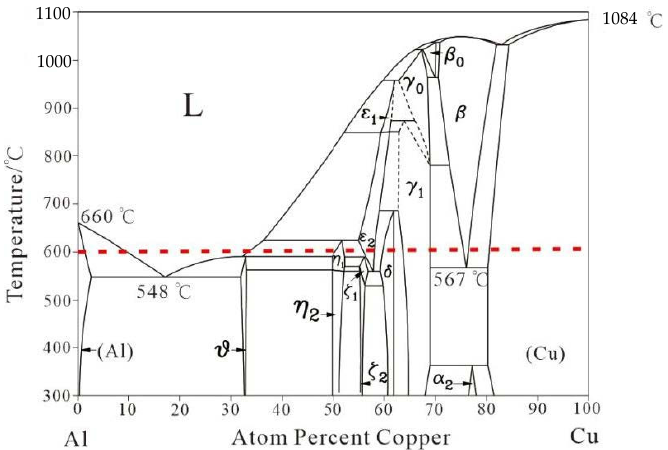
Figure 5. Binary alloy phase diagram of Al-Cu.